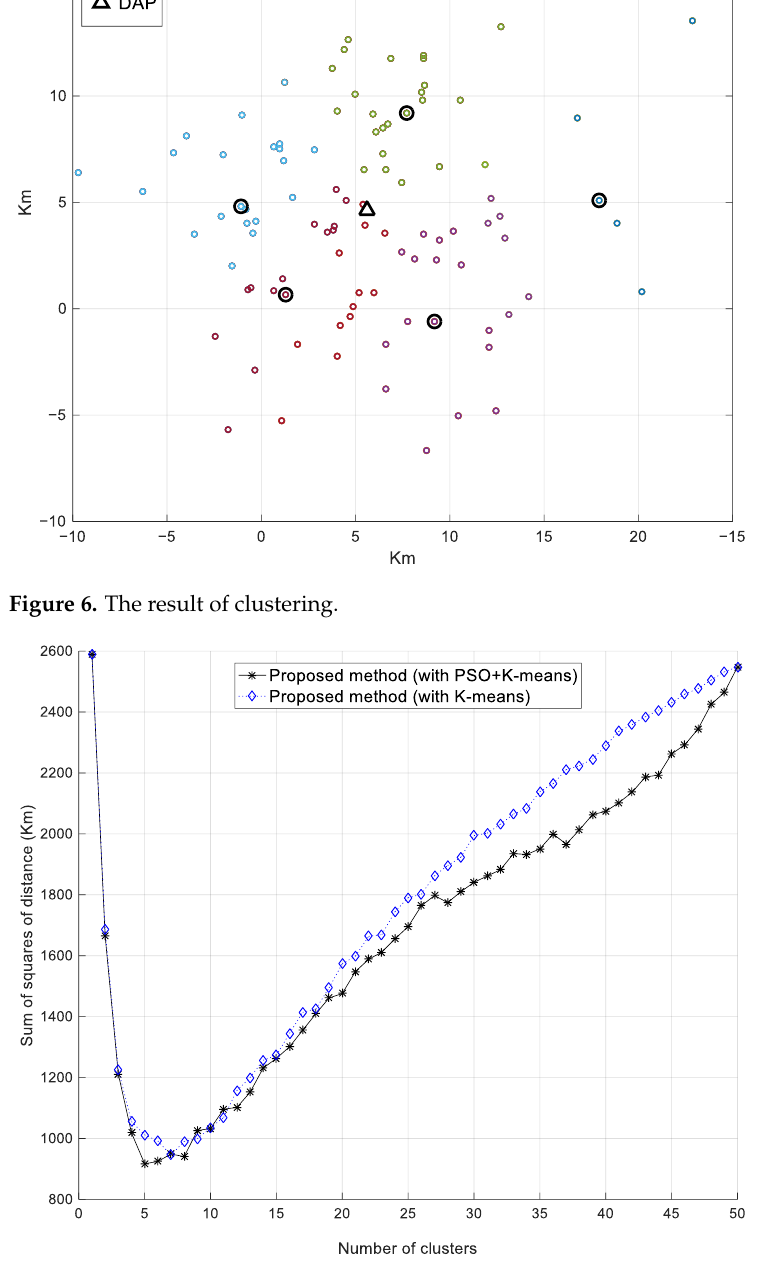
Figure 7. Comparison between K-means and PSO + K-means algorithms.